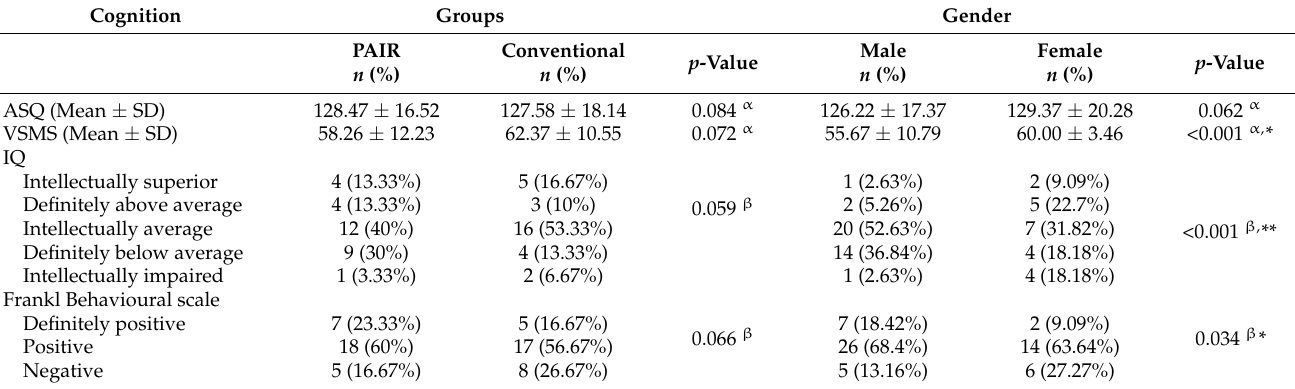
Table 1. Cognitive assessment of the participant according to sociodemographic characteristics.